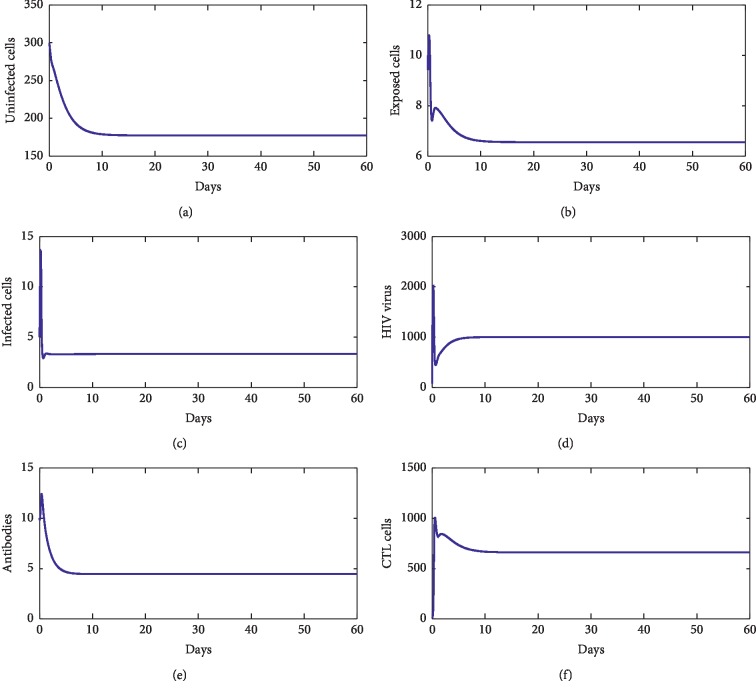
The behavior of the disease for λ=10, d1=0.0139, k1=0.05, d2=0.0495, k2=1.1, d3=0.5776, a=800, d4=0.6, q=0.5, g=10−4, h=0.1, p=0.0024, c=0.15, and b=0.5.